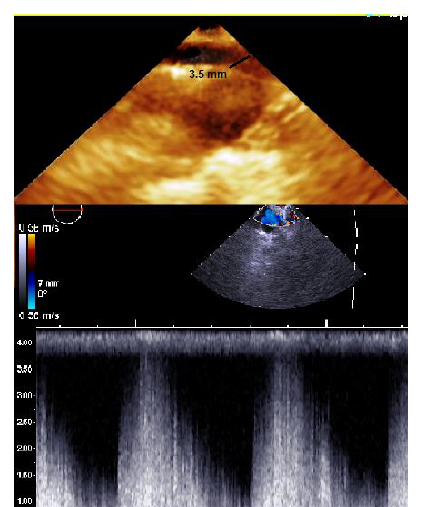
Figure 2 . Aortic CT angiography of aortic